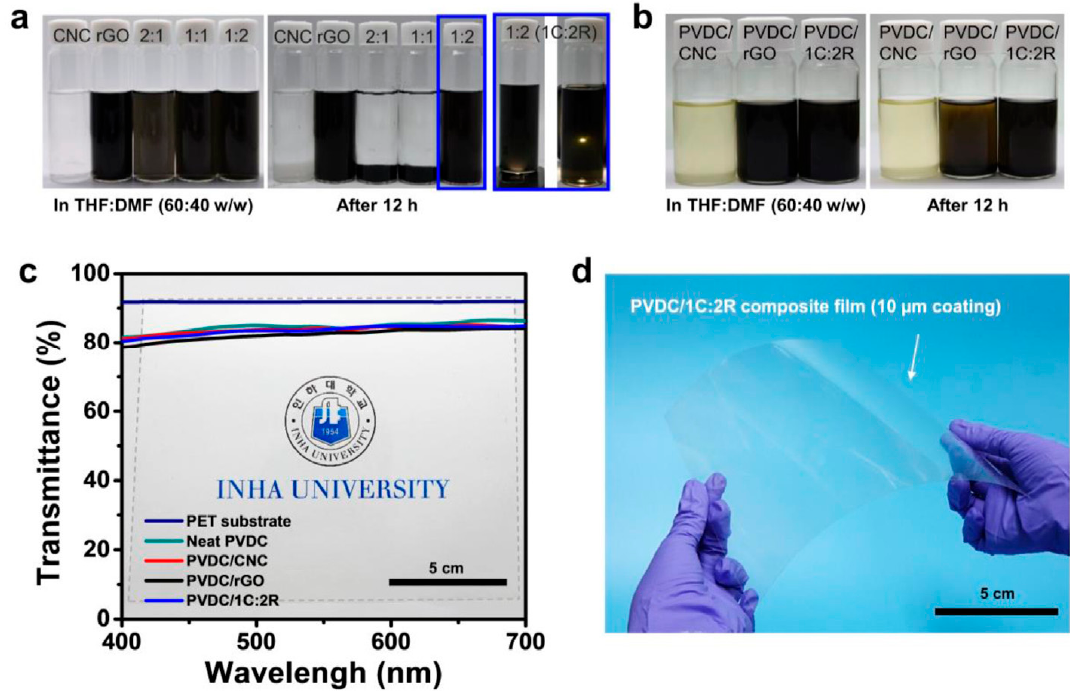
Figure 18. Dispersion stability of nanofillers. CNC, RGO and 1CNC:2RGO (1C:2R) hybrid in ( a ) THF:DMF co-solvent and ( b ) PVDC nanocomposite solutions of 0.1 wt.% fillers loading to PVDC. ( c ) Transmittance results of 0.1 wt.% PVDC / CNC, RGO and 1C:2R nanocomposite films. The 10 mm thick nanocomposite films were deposited on 125 mm thick PET substrates. ( d ) Large area (17 cm × 21 cm) PVDC / 1C:2R–0.1 wt% nanocomposite film was obtained. Reproduced with permission from